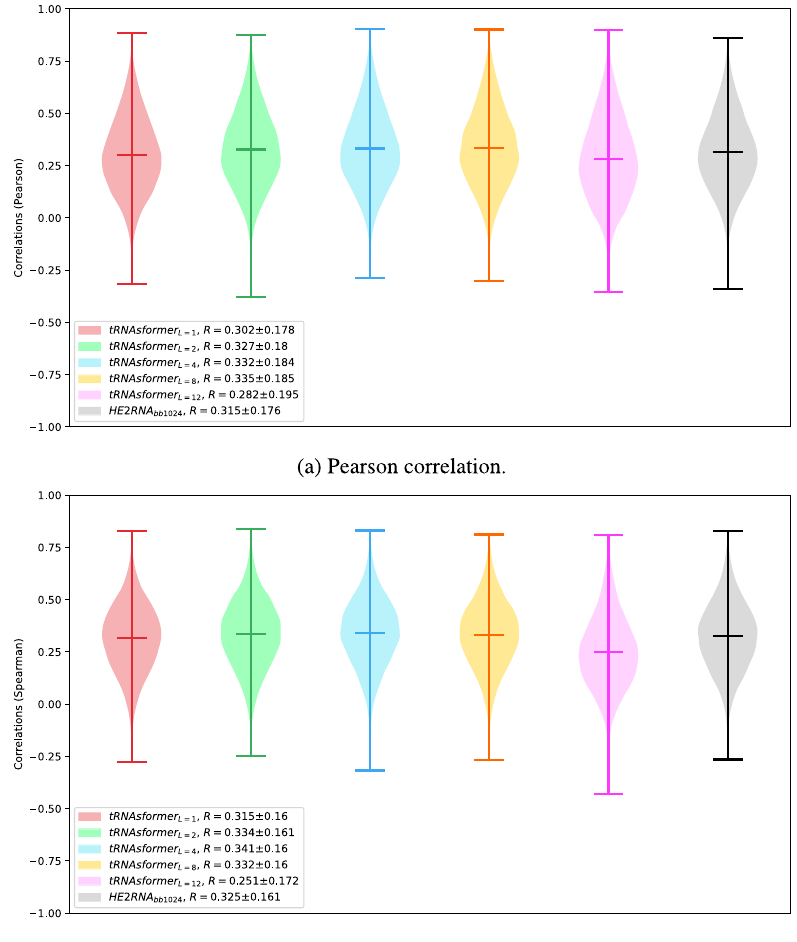
Fig. 2 The distribution of the correlation coef fi cients between 31,793 genes predicted and their true value for the TCGA test set. The violin diagrams depict the distribution, min, max, and mean values of the correlation coef fi cients. a Violin diagrams for Pearson correlation coef fi cients and b violin diagrams for Spearman ’ s correlation coef fi cients. The violin diagrams are plotted for tRNAsformer L for L = (1, 2, 4, 8, 12) and HE2RNA bb1024 . The mean and standard deviation of the correlation coef fi cients are included in the legend for violins from left to right.